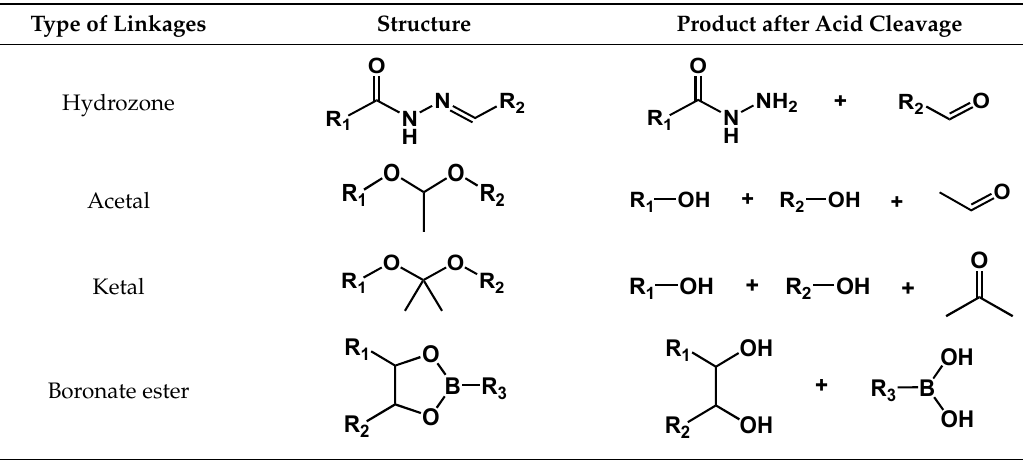
Table 1. Summary of acid-labile Table 1. Summary of acid-labile linkages. Table 1. Summary of acid-labile linkages. Table 1. Summary of acid-labile linkages. Table 1. Summary of acid-labile linkages. Table 1. Summary of acid-labile linkages. Table 1. Summary of acid-labile linkages. Table 1. Summary of acid-labile linkages. Table 1. Summary of acid-labile linkages.